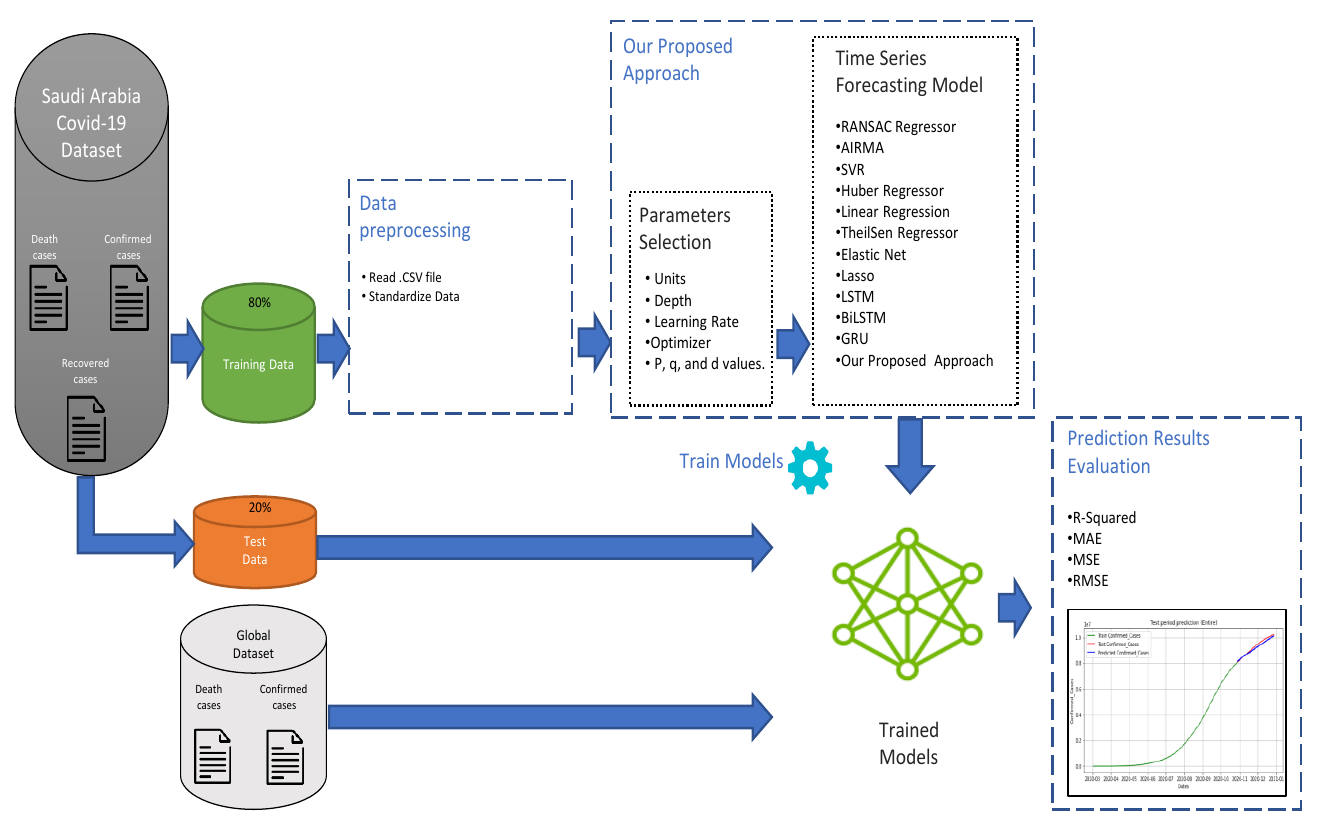
Figure 1. The graphical abstract for our proposed